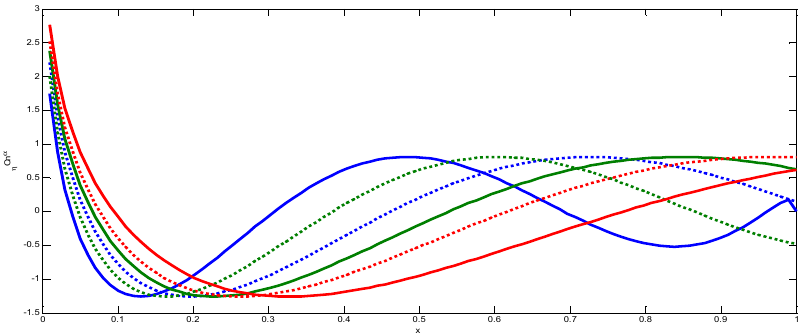
Figure 3. Shows di ff erent values GFCPs with di ff erent values of η = 0.9, 1.5, 1.9,